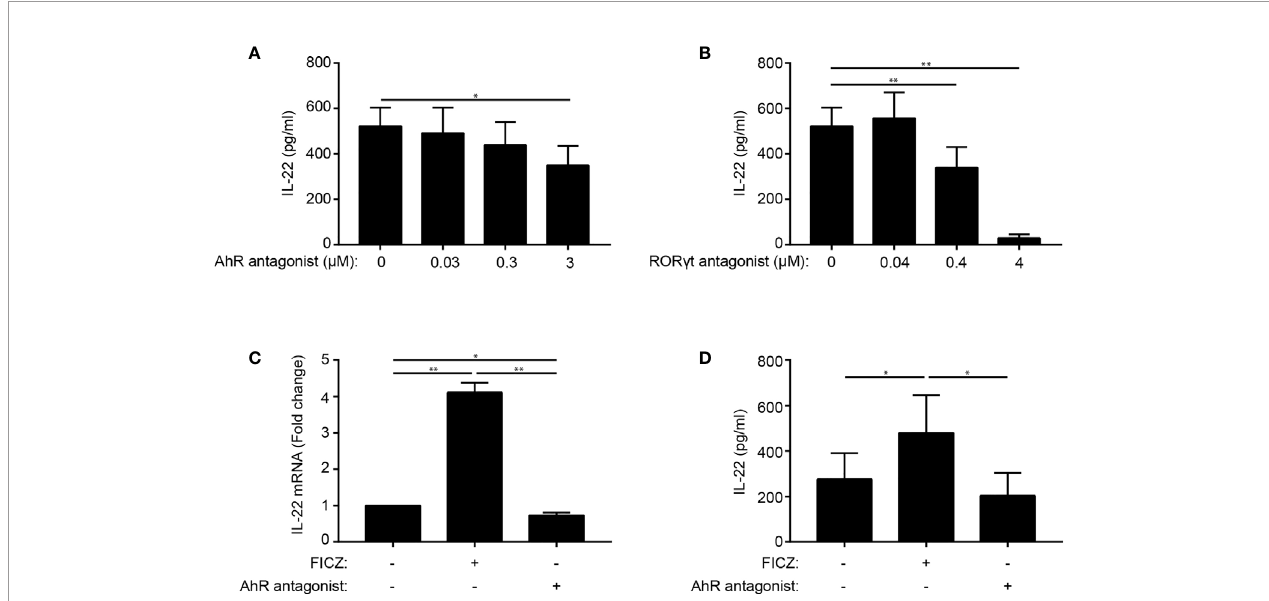
FIGURE 2 | AhR and ROR g t regulate IL-22 production in human Th22 cells. IL-22 in the supernatant of naïve CD4 + T cells co-cultured with allogeneic DC for 96 h in Th22 medium and the presence of (A) the AhR antagonist CH-223191 or (B) the ROR g t antagonist SR-2211 in the indicated concentrations. (mean + SEM, n = 4). (C) Relative mRNA expression and (D) IL-22 production in DC-T cell co-cultures in Th22 medium in the absence or presence of FICZ (0.3 µM) or CH-223191 (3 µM). For mRNA expression, the data are normalized to the values obtained from DC-TC co-cultures in Th22 medium in the absence of FICZ and CH-223191 (mean + SEM, one experiment with 4